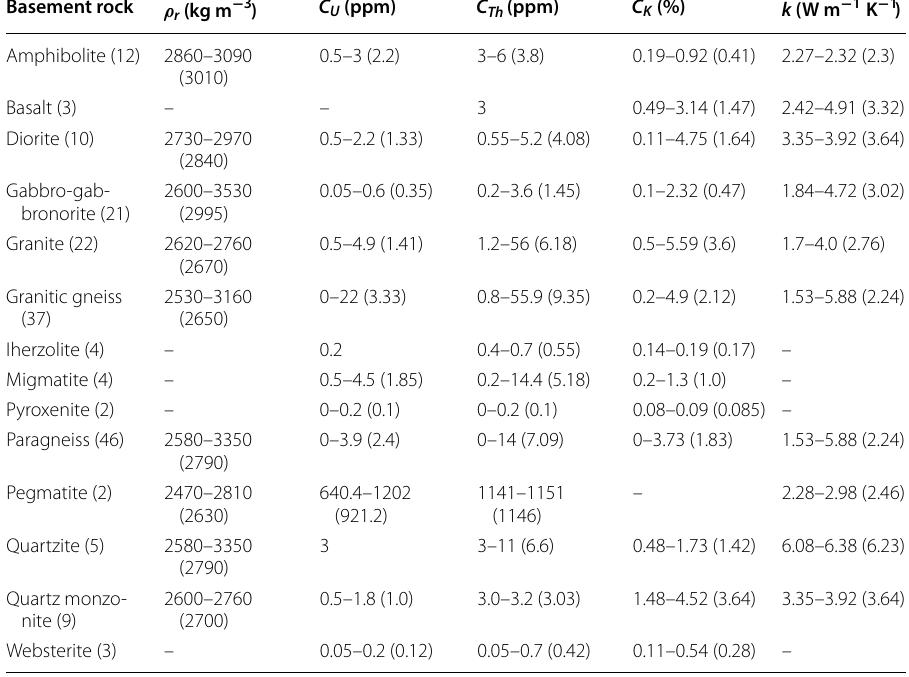
Data sources: densities are from Emslie and Ermanovics (1975), Feininger and Goodacre (1995), Kearey (1978), Paradis (2004). Radiogenic element concentration data are from 163 samples from the SIGÉOM (2018) database. Thermal conductivity data are from Mareschal (2018), Jessop et al. (2005). Average values are in parenthesis. Number of samples for radiogenic element concentration is given in parenthesis after rock